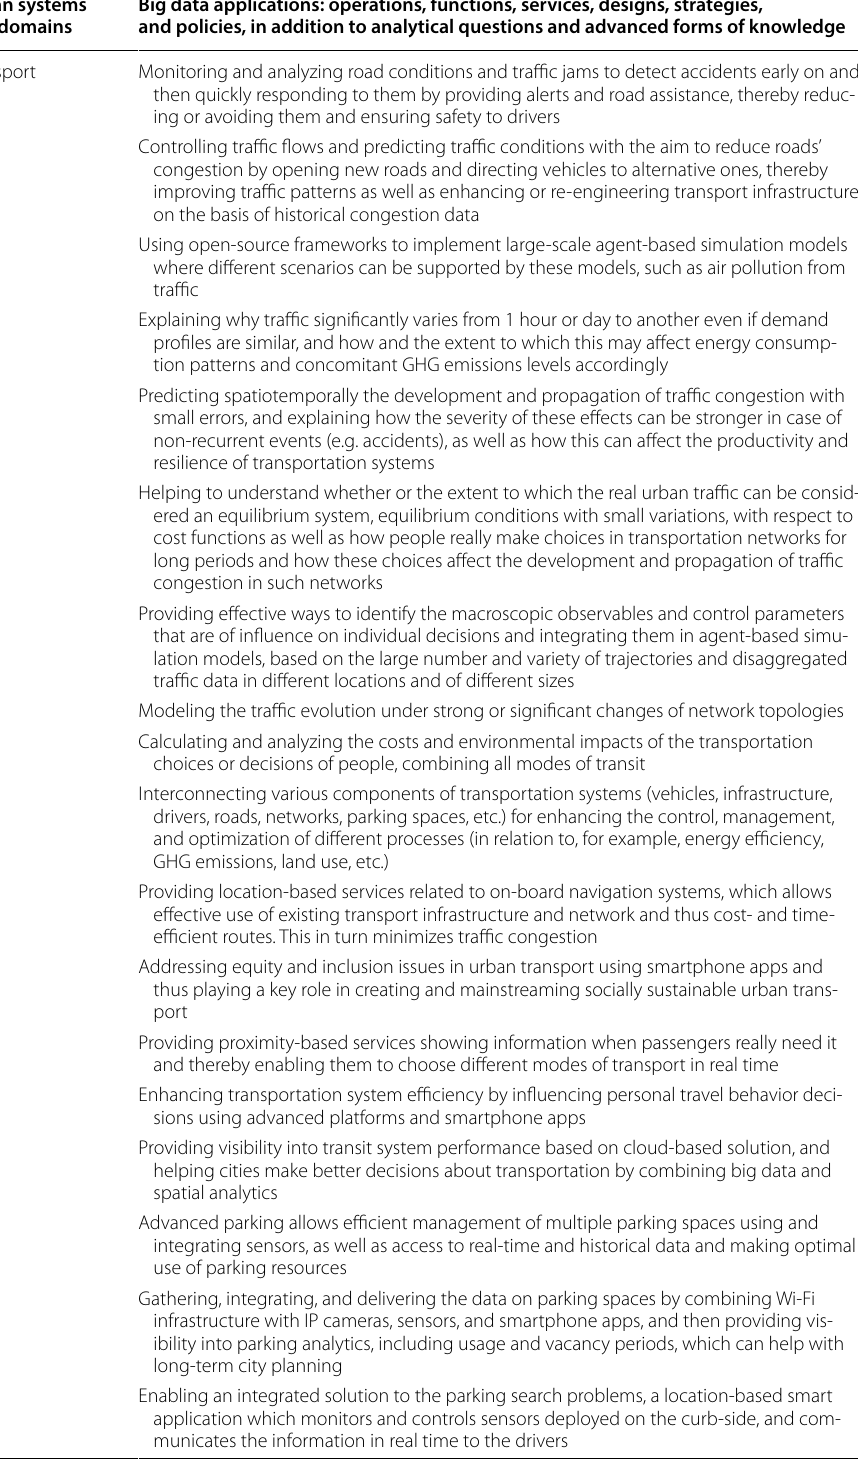
Table 1 Key analytical and practical applications of big data technology for multiple urban domains Urban systems and domains